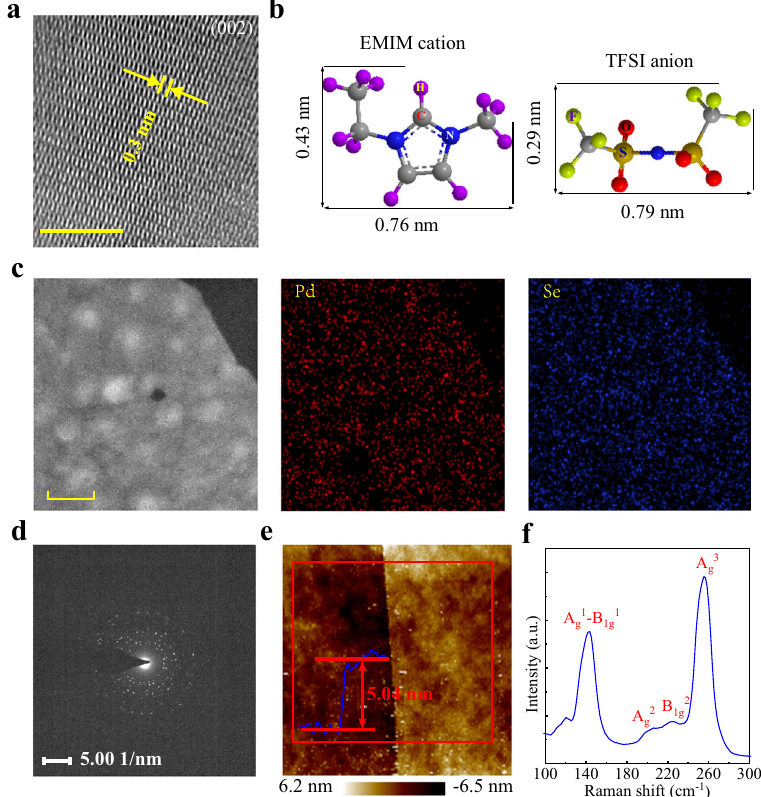
Fig. 2 Material characteristics. a STEM image of the lattice fringes of the 2D PdSe 2 reveals that the interplanar spacing along (002) direction is ~0.3 nm, scale bar: 5 nm. b Chemical structures and size dimension of EMIM cation and TFSI anion in the ion-gel. c EDXS element mapping of 2D PdSe 2 reveals that the atomic ratio Pd:Se is close to 1:2, scale bar: 50 nm. d SAED pattern of the polycrystalline lattice structure of 2D